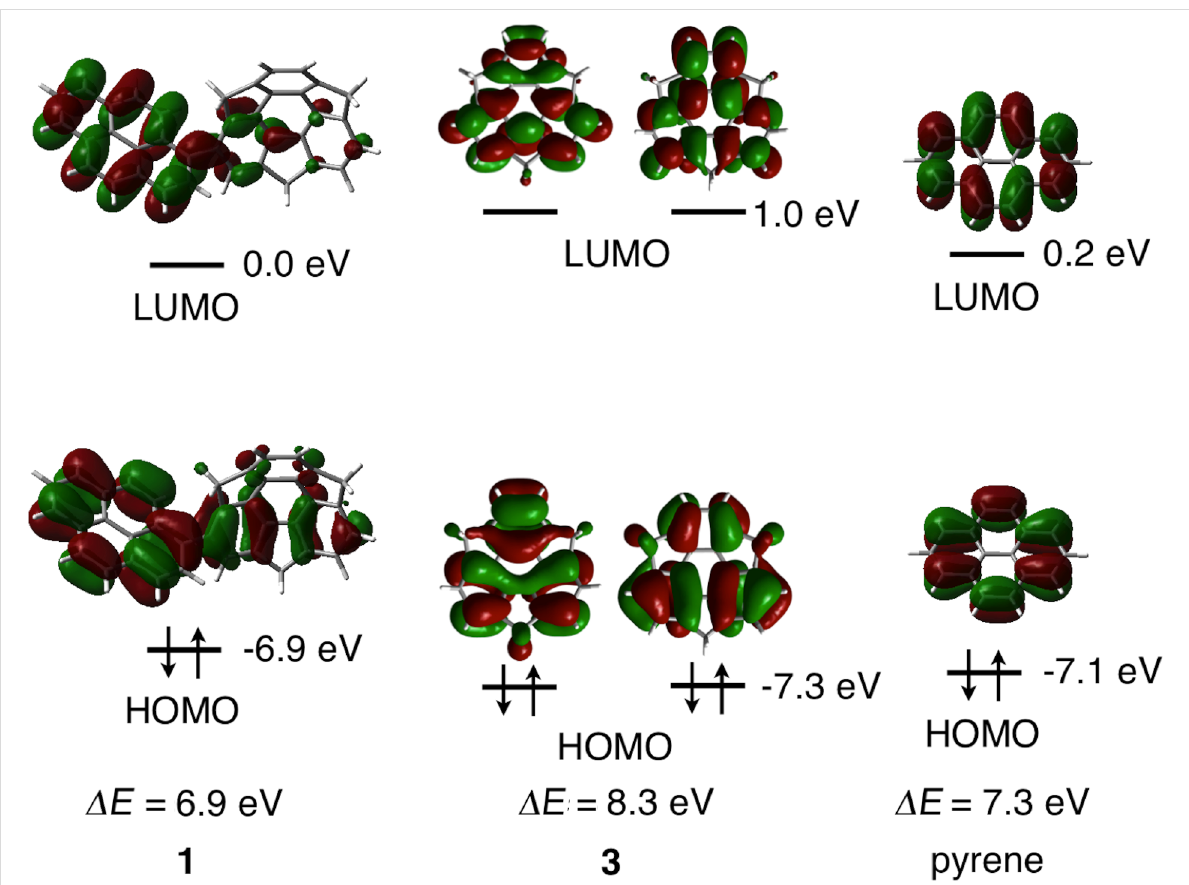
Figure 4: Calculated HOMO and LUMO orbitals and HOMO–LUMO gaps ( Δ E) for 1 , 3 and pyrene ( ω B97XD/6-31G(d)).